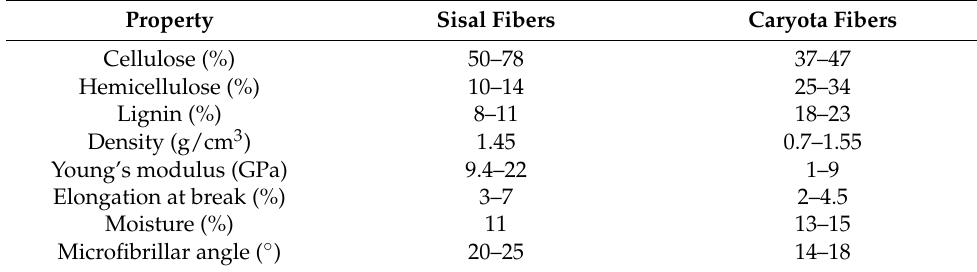
Table 1. The chemical composition and mechanical properties of natural fibers [40,41].